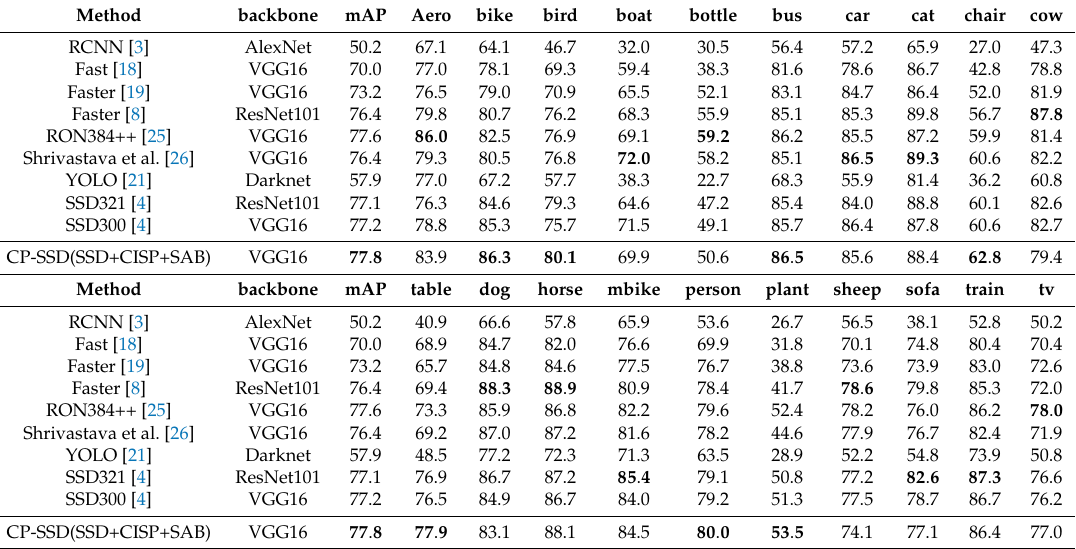
Table 3. Test results of CP-SSD in PASCAL